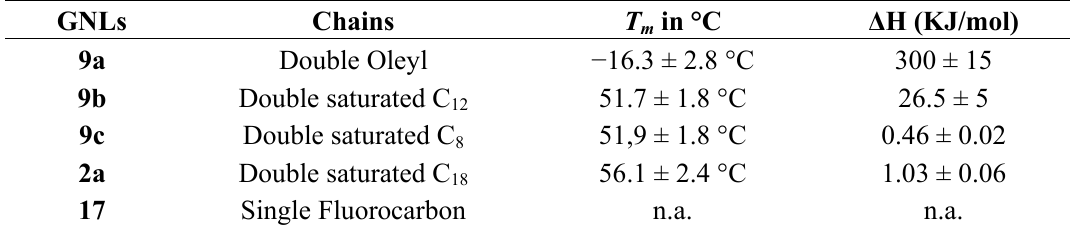
Table 1. Melting temperatures and phase transition enthalpies of GNLs (n.o.: not observed). GNLs Chains